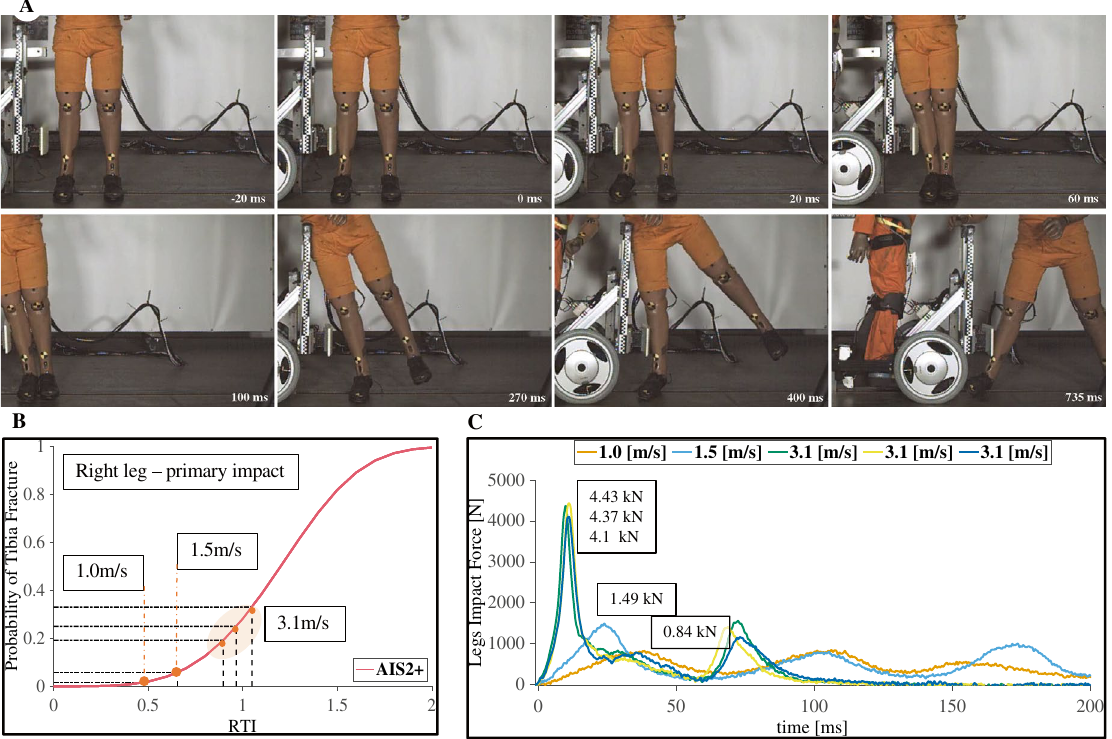
Figure 4. Impact with an adult pedestrian. ( A ) Time lapse of an adult collision at 3.1 m/s (11.1 km/h or 6.9 mph). ( B ) Probability of tibia shaft fracture at the measured speeds. ( C ) Force profile of the impactor measured from the robot side.